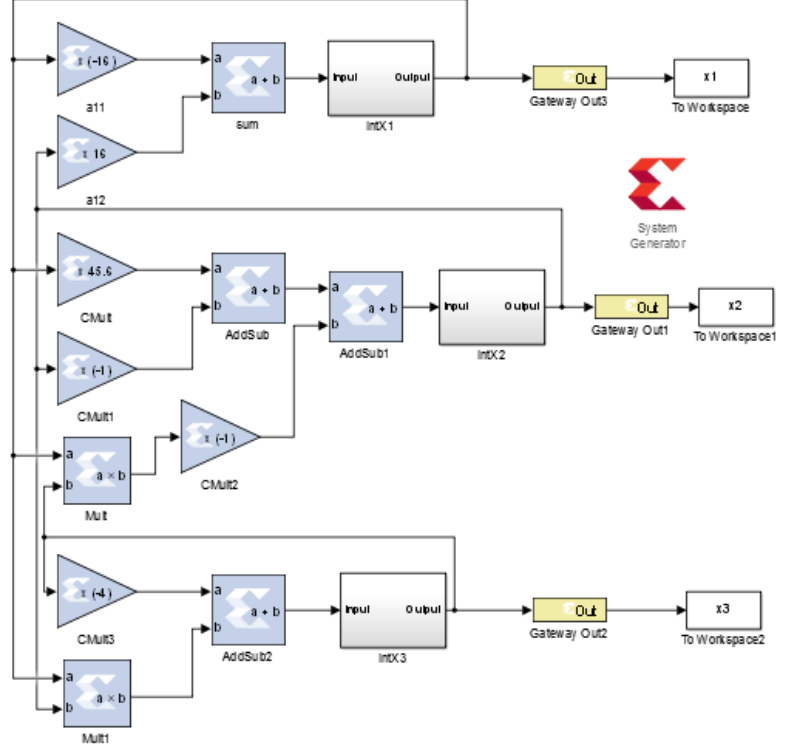
Figure 3. Classical Lorenz system implemented in Simulink R (cid:13) using the Xilinx System Generator